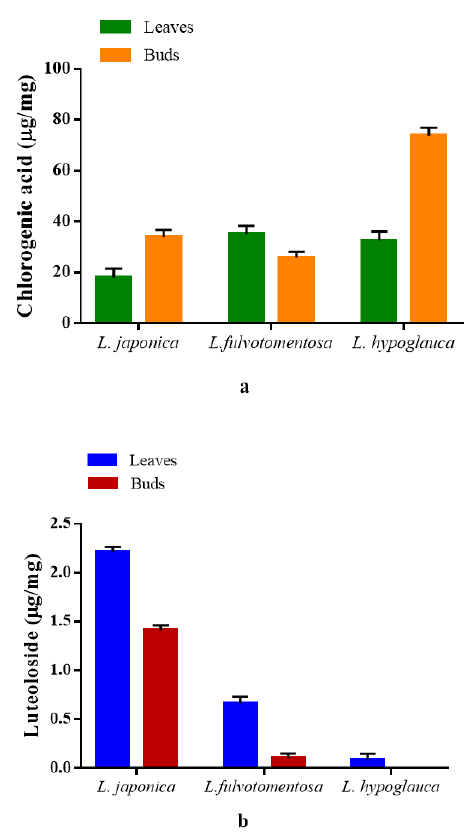
Fig. 3: Contents of CGA and luteoloside in LJ, LF, and LH. The contents of chlorogenic acid (a) and luteoloside (b) in two different parts of the flower buds and leaves of the three species at the golden flowering stage and silver flowering stage that were detected by HPLC.